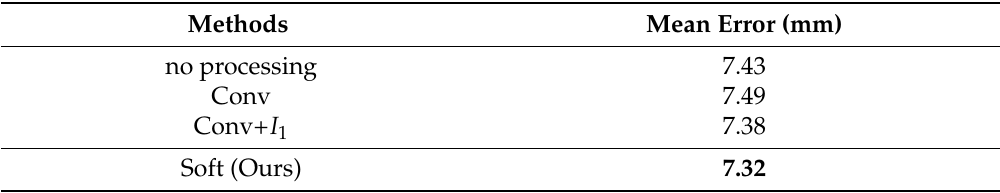
Table 5. Comparison of different input aggregation